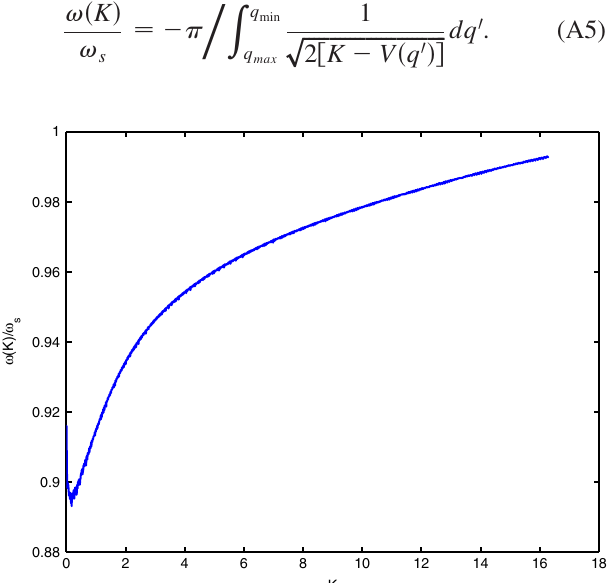
FIG. 13. Incoherent tune shift as a function of K at the thresh- ¼ 0 : 0420 pC = V in the SLC damping old current I th n